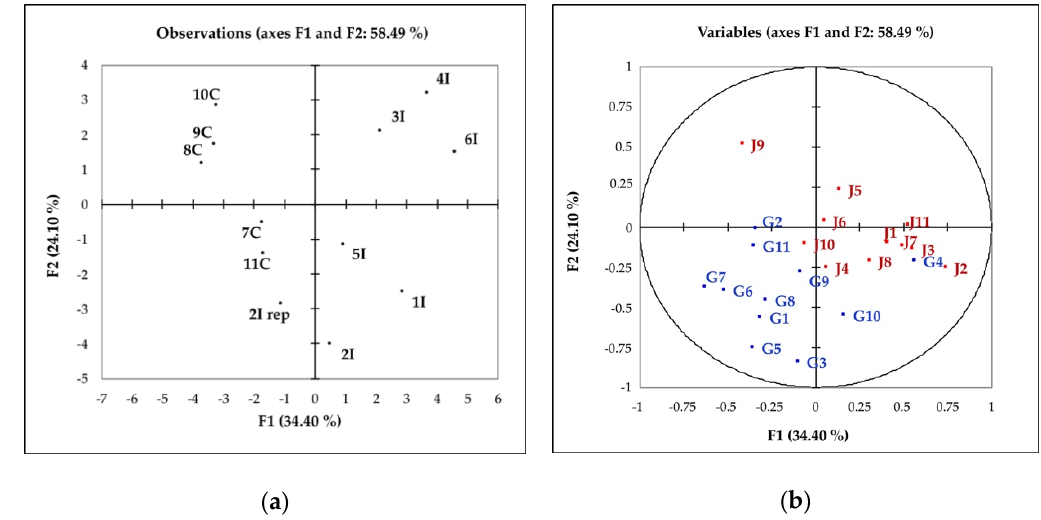
Figure 4. Representation of the Italian and Californian wines by multiple factor analysis according to the Napping X- and Y-coordinates, quality of color and typicality scores provided by the panel of experts. ( a ) Wines distribution (see Table 1 for wine codes); ( b ) distribution of the quality of color (j1–j11 in red) and typicality scores (G1–G11 in blue) (elaborated as supplementary data). Table 3. Typicality and Color scores of the Italian and Californian wines assigned by the experts’ panel (mean values). See Table 1 for wine code, 2I rep is the replicates of the 2I wine 1 .